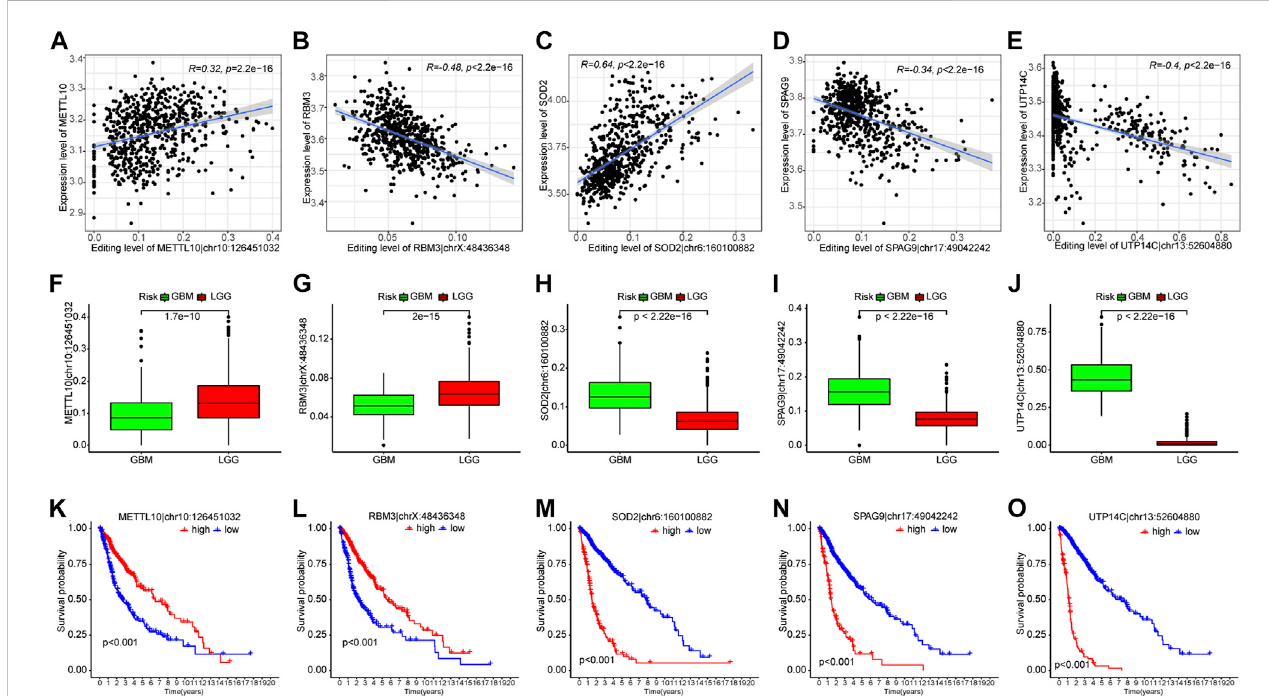
FIGURE 3 Five out of thirty- fi ve PREs showed signi fi cant correlation with corresponding host genes. (A – E) Scatter plots showing the correlation between PRE editing levels and expression of corresponding host genes. (F – J) Difference of PRE editing levels between different grades of gliomas. (K – O) K-M survival analysis of those fi ve RNA-editing in glioma patients (median of editing level as